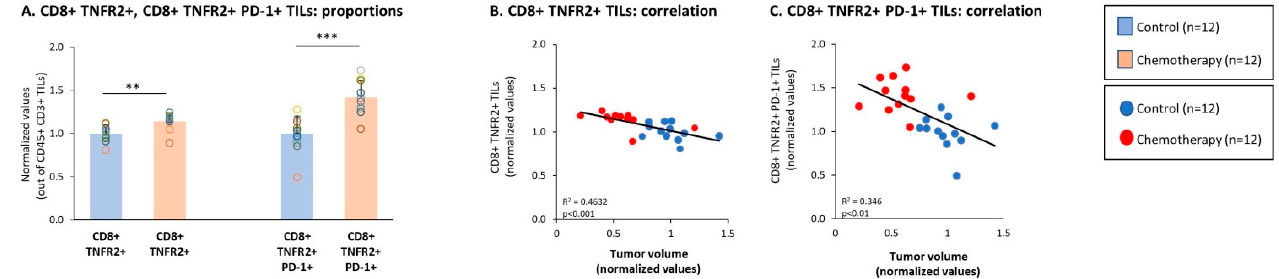
Figure 5. Chemotherapy elevated the proportions of CD8+ TNFR2+ and CD8+ TNFR2+ PD-1+ TILs. Murine 4T1 TNBC cells were syngrafted to BALB/c mice in the presence of chemotherapy or a vehicle control; procedures and analyses were performed as described in Figure 3. ( A – C ) CD8+ TNFR2+ and CD8+ TNFR2+ PD-1 TILs, gated out of CD45+ CD3+ cells. ( A ) Proportions of CD8+ TNFR2+ and CD8+ TNFR2+ PD-1+ TILs. ( B , C ) CD8+ TNFR2+ and CD8+ TNFR2+ PD-1+ TILs, respectively, correlated with tumor volumes. In the proportion and correlation analyses, the average value of the vehicle-treated group in each biological repeat was given the value of 1 and the values of all mice analyzed in that repeat were normalized accordingly. The value of each mouse is presented as a dot. *** p < 0.001, ** p < 0.01 (two-tailed unpaired Student’s t -test; correlation analyses: Pearson; T.DIST).